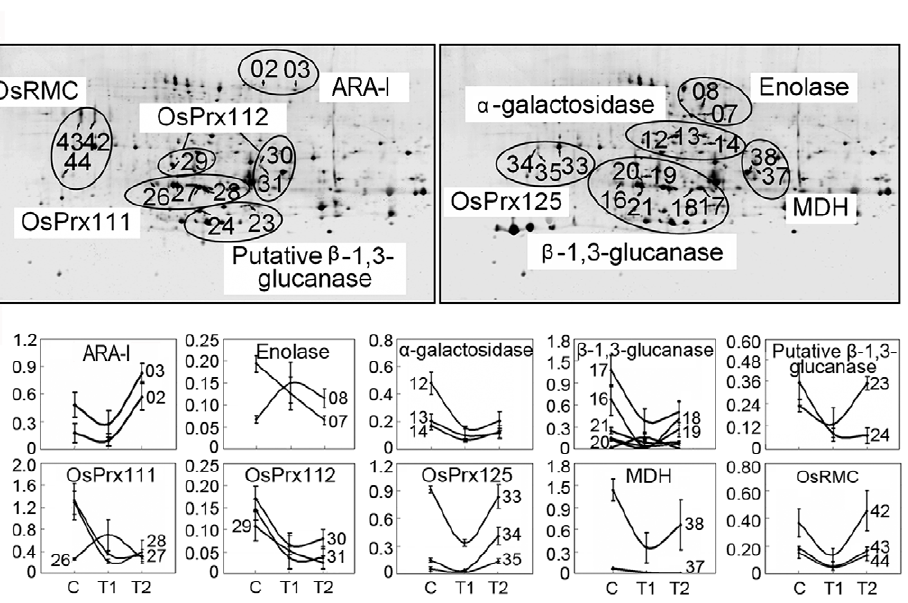
Figure 4. Close-up of possible isoforms detected by 2-DE (A) and their expression profile patterns (B). All 29 differentially expressed protein spots, matching 10 different proteins, are shown. T1 and T2 represent H 2 O 2 treatments of 300 m M and 600 m M, respectively. ARA-I, a -